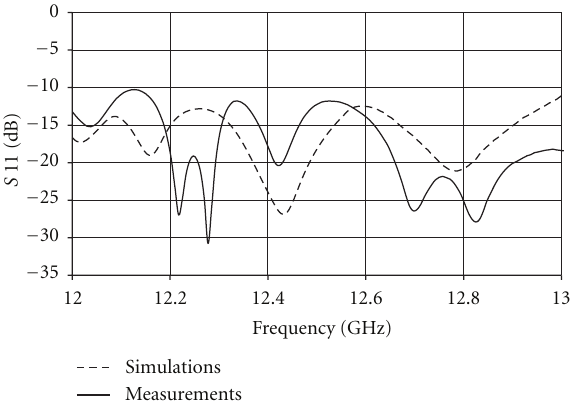
Figure 10: Comparison between measurements and simulations results for S